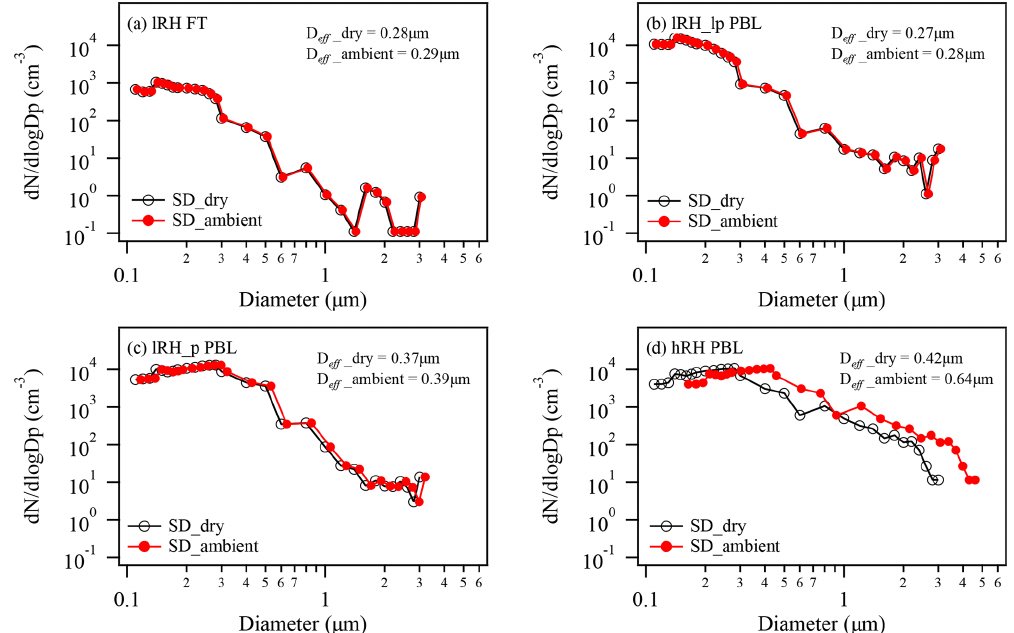
Figure 5. Measured dry size distribution and estimated ambient size distribution by considering the hygroscopic growth of aerosol for (a) lower free troposphere under low RH (lRH FT), (b) PBL under low RH and less polluted condition (lRH_lp PBL), (c) PBL in the polluted but low RH condition (lRH_p PBL), and (d) PBL under high RH condition (hRH